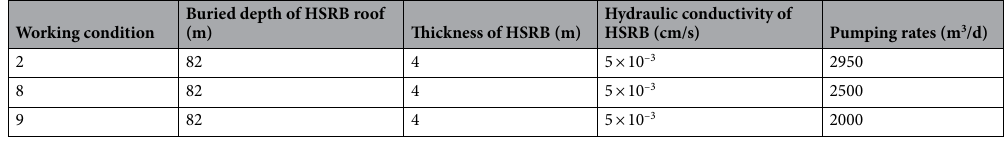
Table 5. Working conditions of different pumping rates.